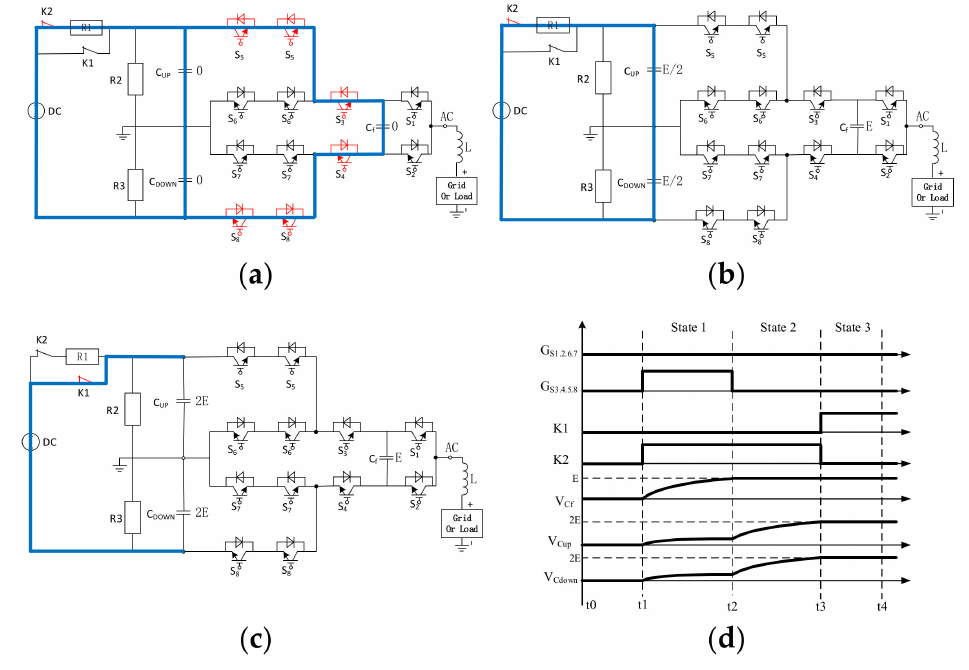
Figure 15. Proposed soft start-up process. ( a ) State 1. ( b ) State 2. ( c ) State 3. ( d ) Sequence